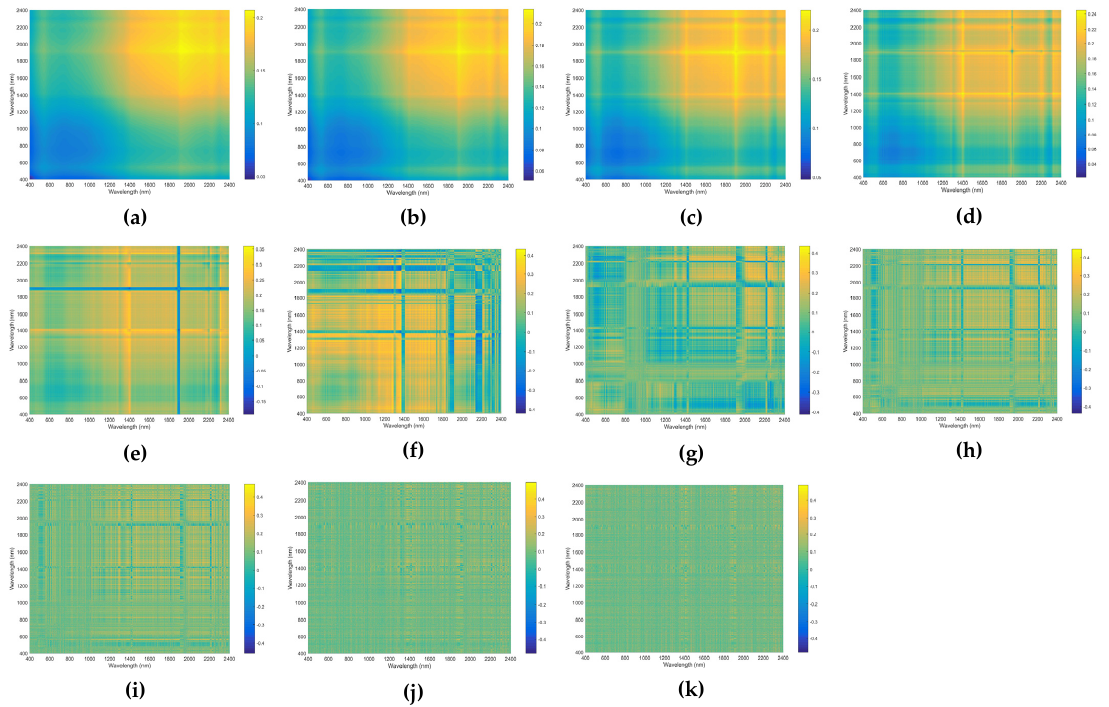
Figure A4. Correlation coefficients between soil Hg and product index of the reflectance processed by ( a ) 0-order, ( b ) 0.2-order, ( c ) 0.4-order, ( d ) 0.6-order, ( e ) 0.8-order, ( f ) 1-order, ( g ) 1.2-order, ( h ) 1.4-order, ( i ) 1.6-order, ( j ) 1.8-order, ( k ) 2-order.